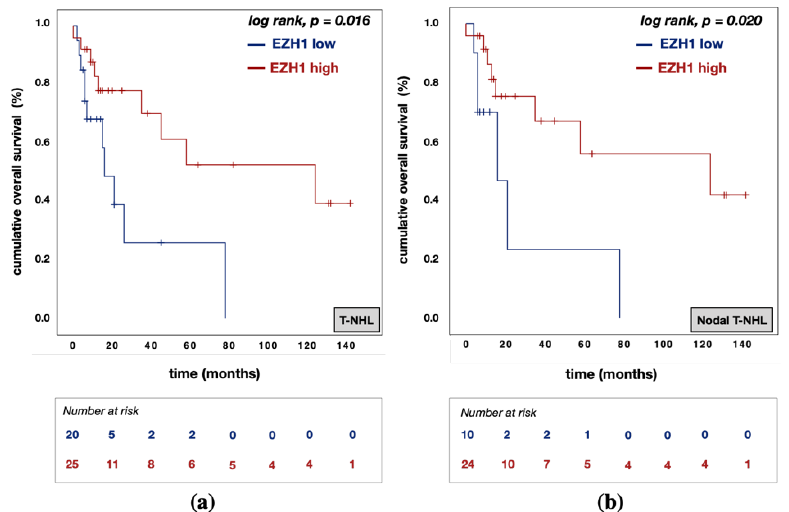
Figure 6. Kaplan–Meier (KM) curves for overall survival (OS) according to EZH1 protein expression. ( a ) KM curve for OS according to EZH1 protein expression in T-NHL; ( b ) KM curve for OS accord- ing to EZH1 protein expression in nodal T-NHL. Abbreviations: T-NHL —T-cell non-Hodgkin’s lymphomas; EZH1 low —EZH1 protein expression with an H-score below 4; EZH1 high —H3K27me3 protein expression above or equal to an H-score of